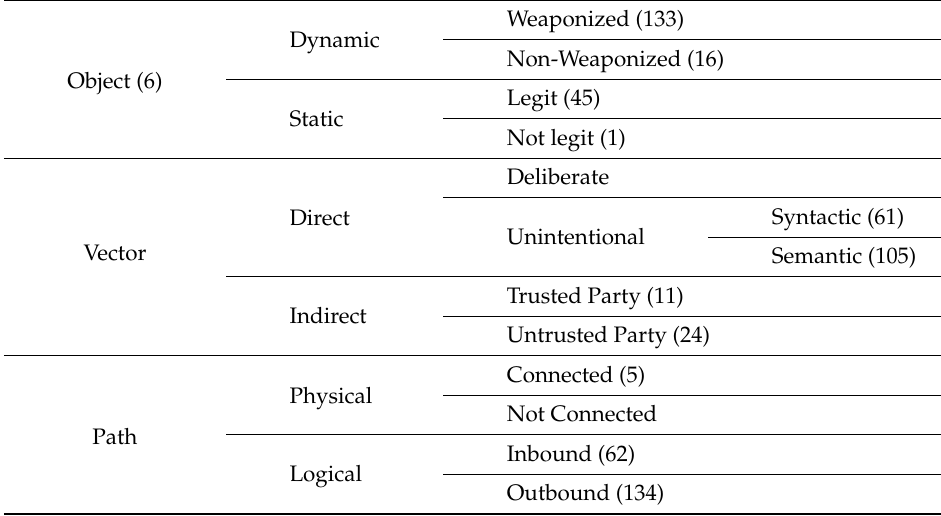
Table 6. MITRE ATT&CK groups